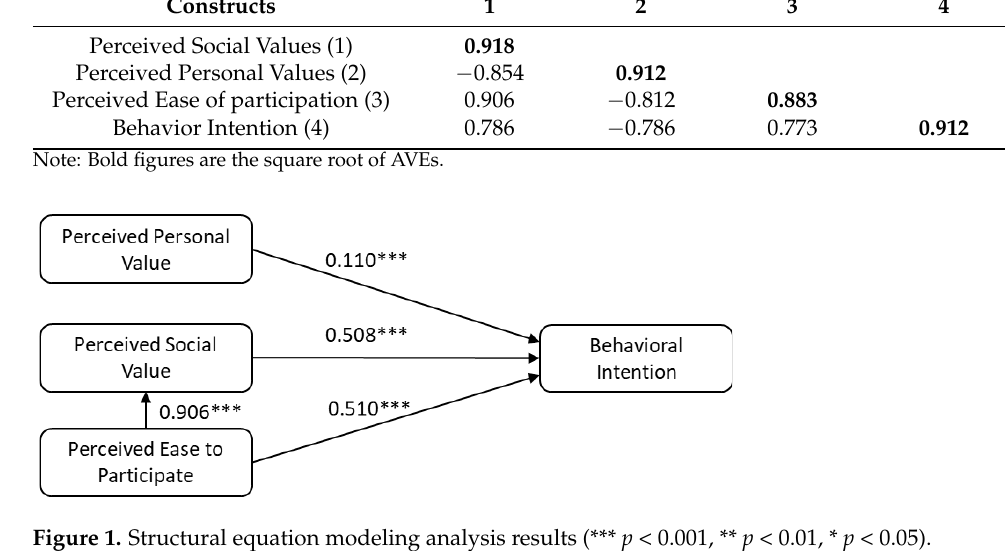
Figure 1. Structural equation modeling analysis results (*** p < 0.001, ** p < 0.01, * p < 0.05).